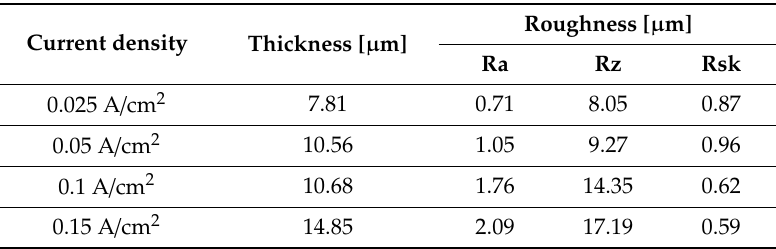
Figure 4. Morphology of the PEO coating prepared in the electrolyte with 10 g/L of Na 3 PO 4 .12H 2 O and current density of 0.025 A/cm 2 ( a ), 0.05 A/cm 2 ( b ), 0.1 A/cm 2 ( c ) and 0.15 A/cm 2 ( d ). Table 4. Thickness and roughness parameters of the PEO coatings prepared in electrolyte with 10 g/L of Na 3 PO 4 .12H 2 O.